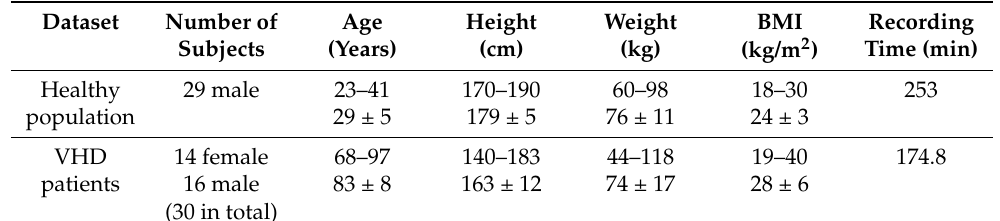
Table 1. Basic characteristics of the datasets. Aggregated values are expressed as the range (min–max) and mean ± SD.